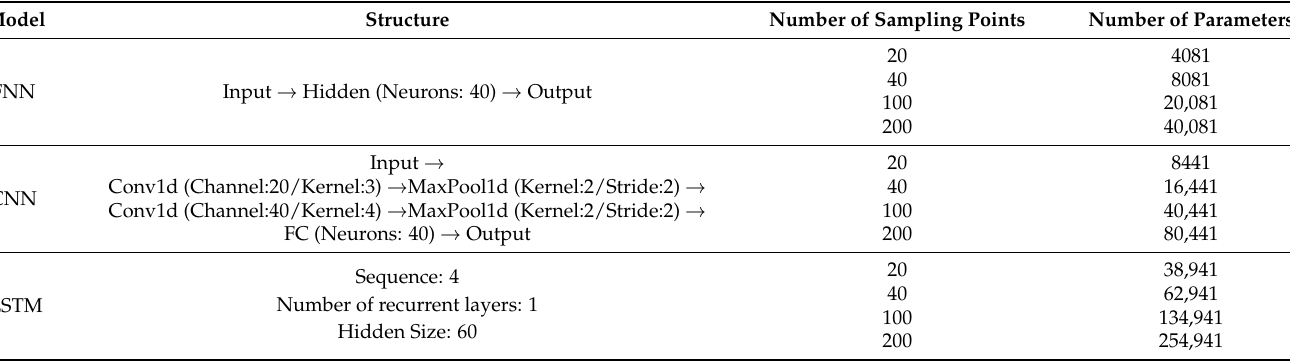
Table 2. Structure and parameters of neural